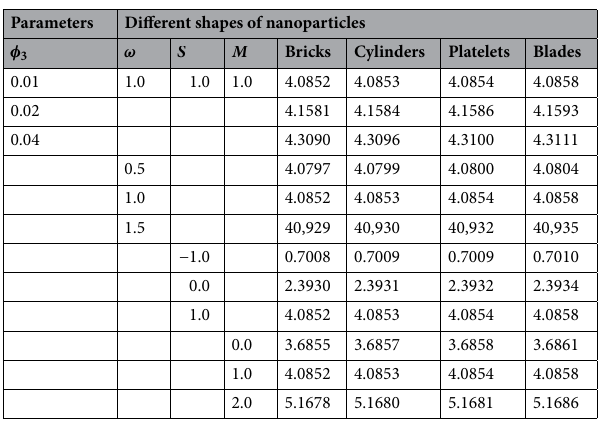
− k mnf θ ′ ( h ) against different involved parameters. k f (cid:31) (cid:30)